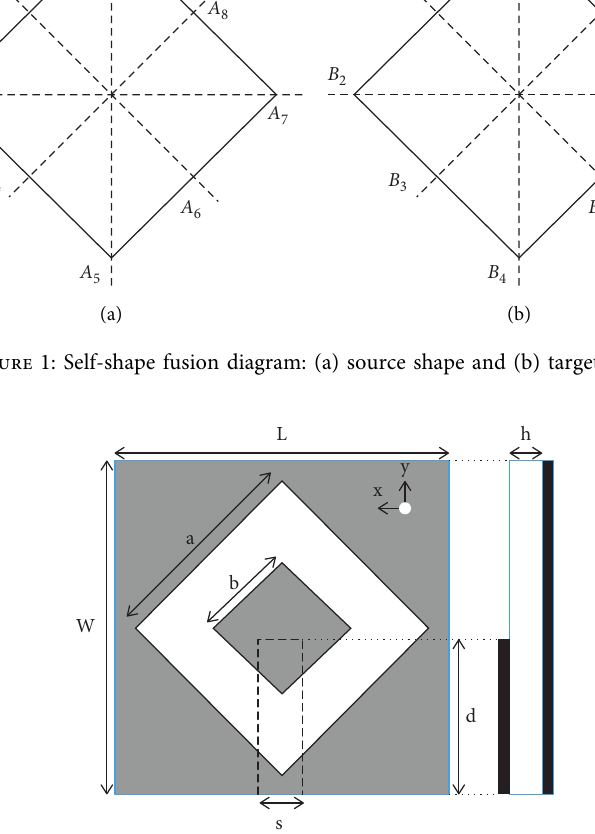
Figure 2: Geometry of reference